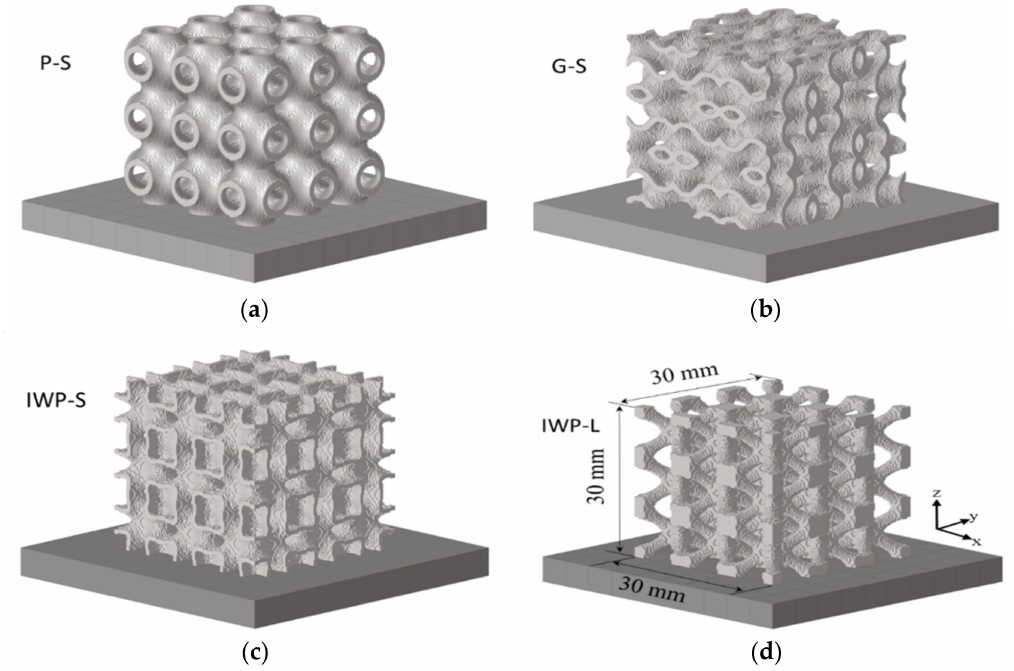
Figure 6. 3 × 3 × 3 cell configuration FEA models used for AM buildup simulation on an IN718 baseplate: ( a ) P-S ( b ) G-S ( c ) IWP-S, and ( d )